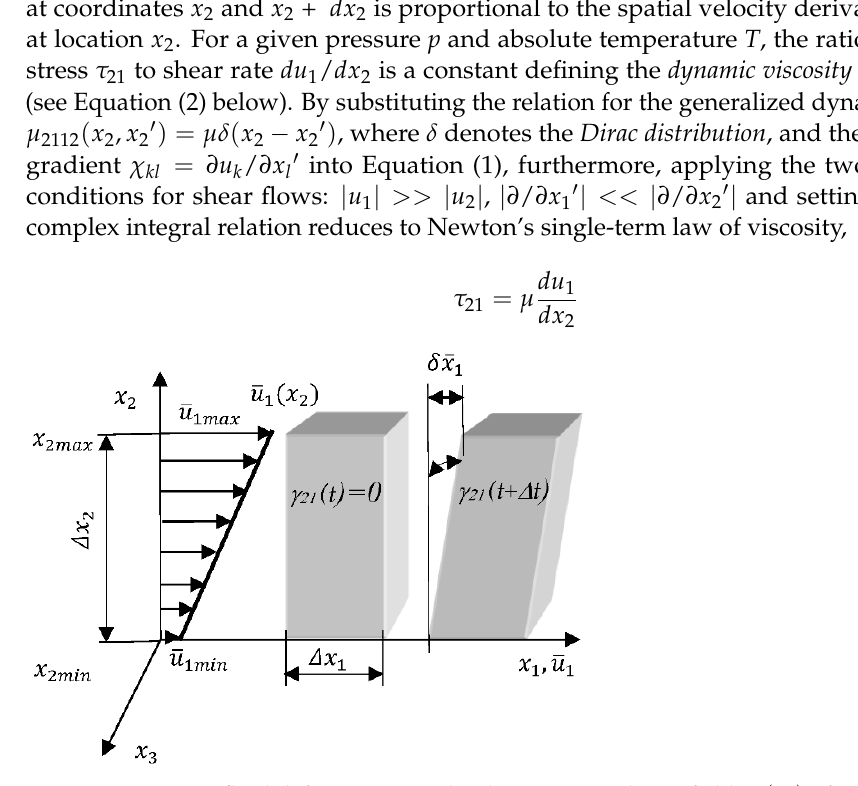
Figure 1. Dynamic fluid deformation δ x 1 by the average velocity field u 1 ( x 2 ) of an element of an incompressible fluid participating in a laminar, transitional, or turbulent shear flow. Reprinted from Egolf and Hutter, 2019, Springer Edition Cham, Switzerland, reproduced with